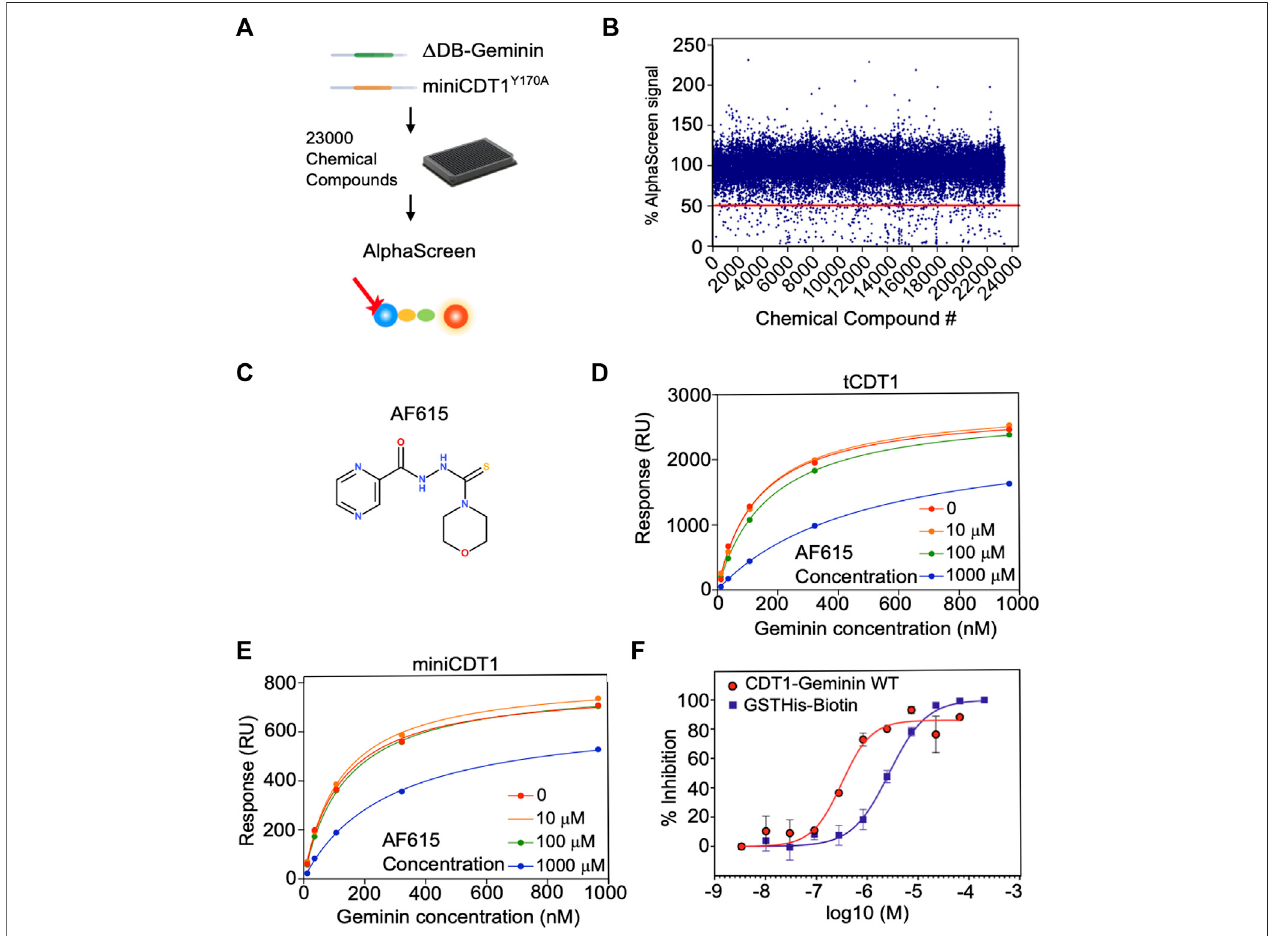
FIGURE 1 | Chemical compound AF615 disrupts the CDT1-Geminin protein complex in vitro . (A) Schematic representation of the high-throughput screening for the identi fi cation of chemical compounds inhibiting the CDT1-Geminin protein interaction complex using AlphaScreen technology. Δ DB-Geminin and miniCDT1Y170A mutantproteinswereusedasscreeningtargets. (B) In-vitro high-throughputscreeningforchemicalcompoundsinhibitingtheCDT1-Gemininprotein-proteininteraction. Intotal23,360compoundswerescreenedatasingleconcentrationof5 μ Musinga384-wellplateformat.Usingaselectioncriterionof > 50%signalreduction(solid line),360primary “ hits ” wereidenti fi edandsubjectedtofurthervalidation.Thex-axisrepresentsthedifferentcompounds, whilethey-axisrepresentsthepercentage(%) of AlphaScreen signal, as normalized against the median value of AlphaScreen signal in presence ofthe compounds arrayed in each plate. (C) Chemical structure of the chemical compound AF615. (D,E) Compound AF615 inhibits Geminin binding to CDT1 in a dose dependent manner. Graphical representation of Surface Plasmon Resonance (SPR) analysis of tCDT1 and miniCDT1 binding to Geminin in the presence of different concentrations of compound AF615. The x-axis represents Geminin concentrations,whilethey-axisrepresentstheResponse(RU). (F) InhibitionofCDT1-Gemininwildtypecomplexformationinadosedependentmannerinthepresence of AF615 using Alphascreen technology. X-axis represents compound concentration on a logarithmic scale, while y-axis represents percentage (%) inhibition. AlphaScreen Signal was determined for each compound concentration in presence of the Geminin/CDT1 wild type complex (red line) and a single fusion protein containingbothaGST-andaHis-tag(blueline),asacontrol.Eachdatapointisthemean±SDfromduplicatemeasurements.Datapointswere fi ttedusingthenon-linear regression function log (inhibitor) versus response variable slope (four